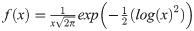
CDFs and best fit of path lengths.Data in subfigures (a), (b), (c) and (e) are best described by a Gilbrat distribution function with a probability density function of f(x)=1x2πexp(−12(log(x)2)). Data in subfigure (d) is best described by a beta function with a probability density function of f(x,a,b)=γ(a+b)xα−1(1−x)b−1γ(a)γ(b), for 0 < x < 1, a > 0, b > 0. Data in subfigure (f) is best described by a Weibull min distribution function with a probability density function of f(x, c) = cxc−1exp(−xc), for x > 0, c > 0. Table 2 shows the first moments of the data. For supporting information, see S2 and S3 Tables.